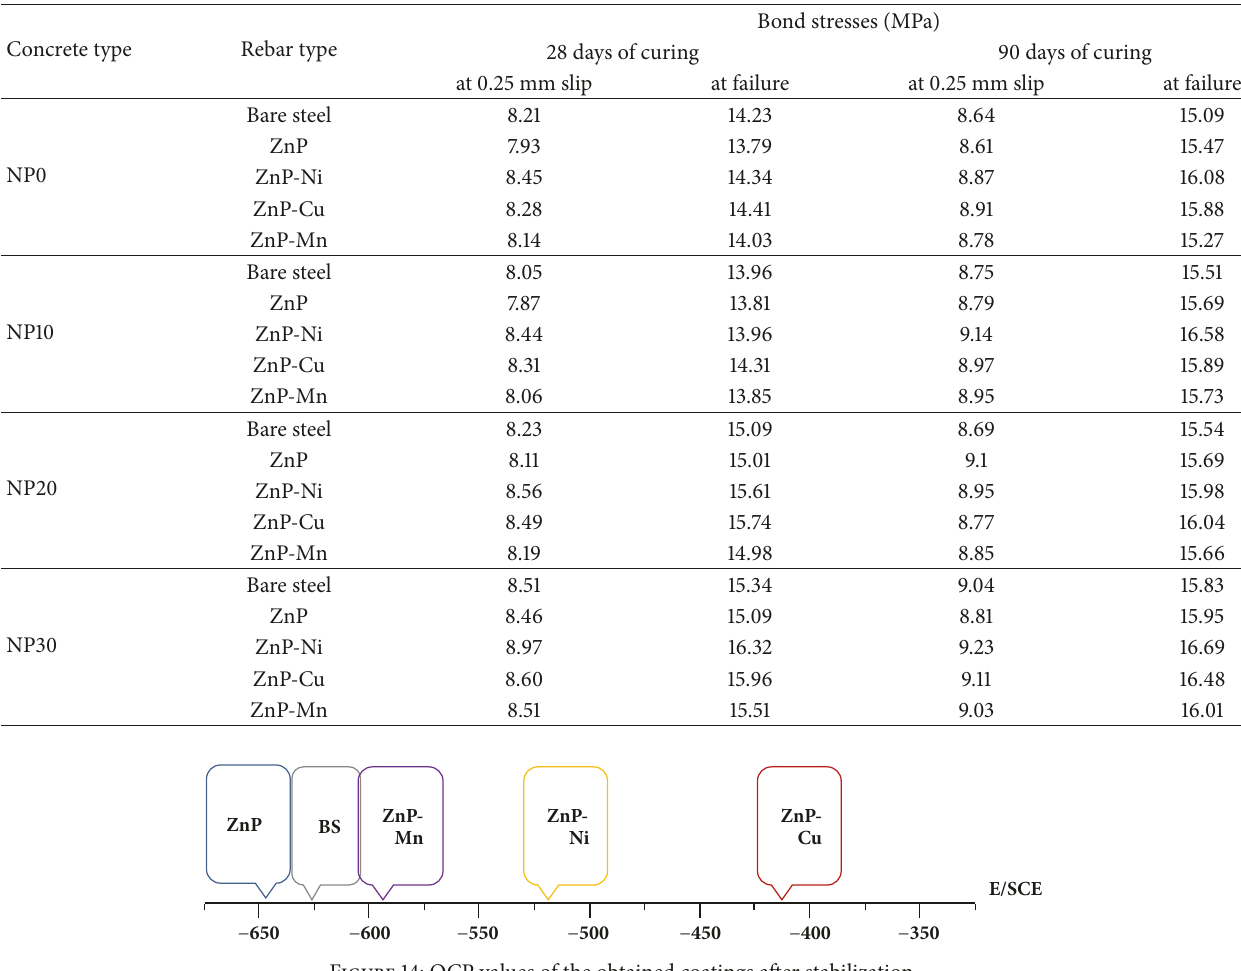
Figure 14: OCP values of the obtained coatings after stabilization.